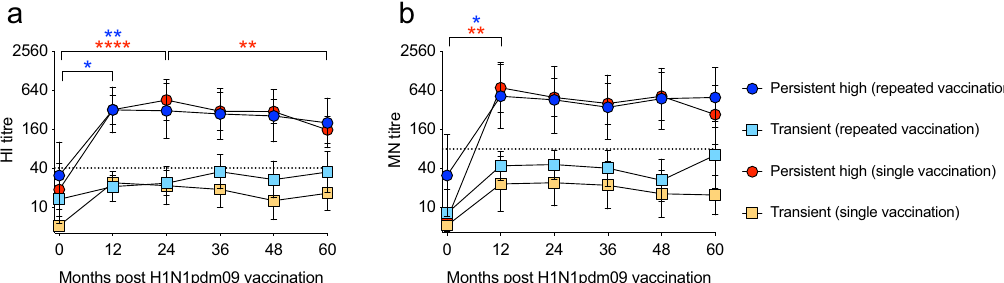
Fig. 2 High antibody titres 12 months post H1N1pdm09 vaccination persisted up to four subsequent years, regardless of repeated seasonal in fl uenza vaccination. The HI titres ( a ) and MN titres ( b ) against H1N1pdm09 virus were measured annually before each in fl uenza season in persistent high responders (circle) and transient responders (square) after repeated vaccination (blue and turquoise) or single vaccination (red and orange). The geometric mean titres and 95% con fi dence intervals are presented. The dotted line at HI = 40 and MN = 80 represent a surrogate correlate of protection. Statistical differences between different time points were tested using two-way ANOVA with Tukey test for multiple comparisons. * P < 0.05, ** P < 0.01, **** P < 0.0001.